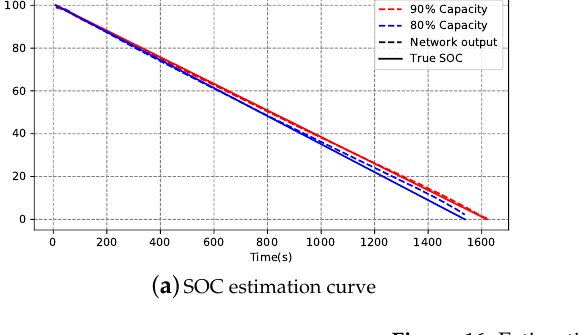
Figure 16. Estimation results at 45 ◦